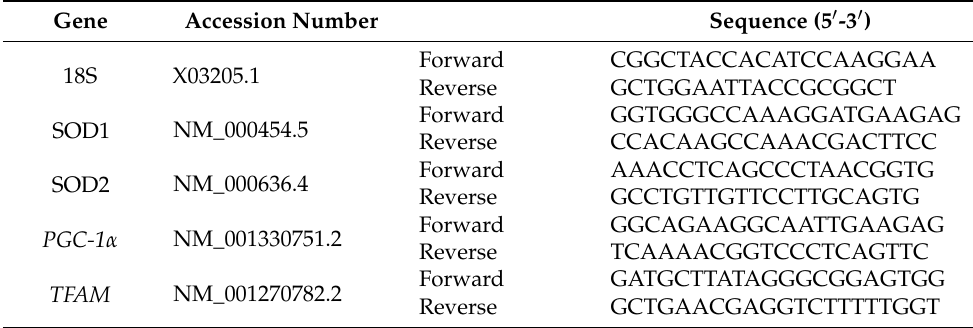
Table 1. Primers